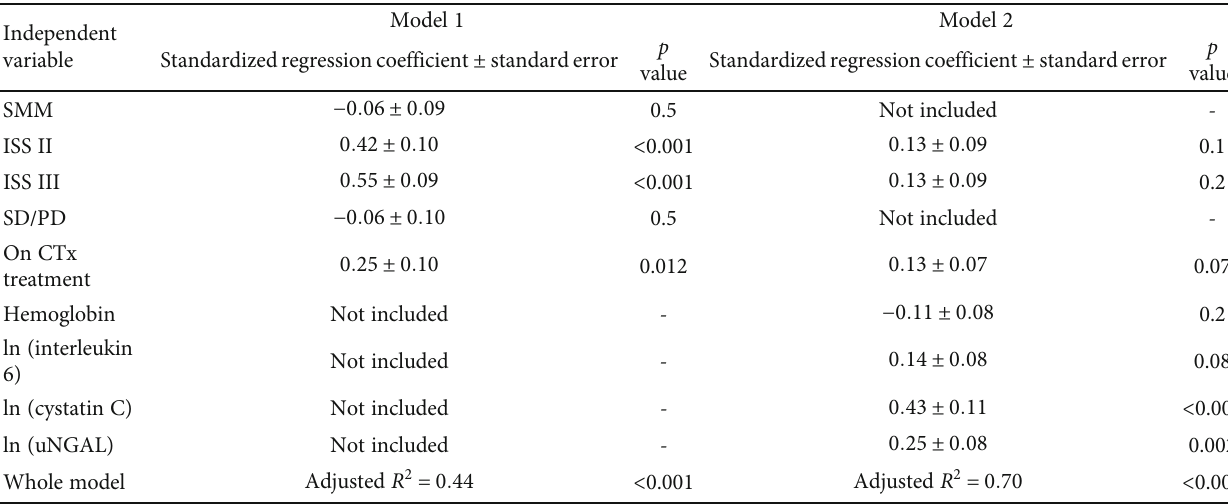
Table 1: Multiple regression models showing the independent predictors of serum GDF-15 among the studied patients with MM. The right- skewed variables (including GDF-15) were ln-transformed before